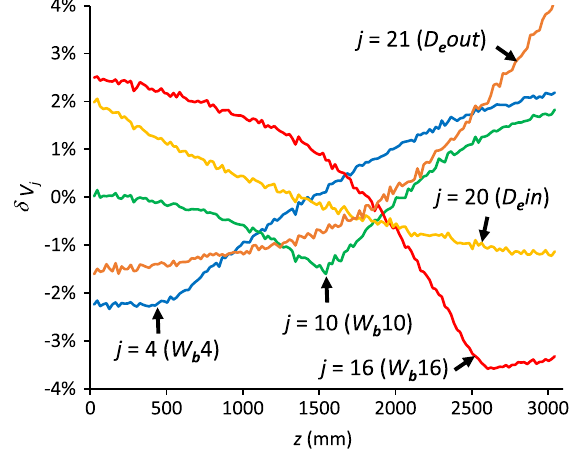
FIG. 4. Normalized deviations of the intervane voltage δ V j for parameters of W b ’ s and D e ’ s. For W b ’ s, only three curves from a total of 19 W b ’ s are plotted for graph